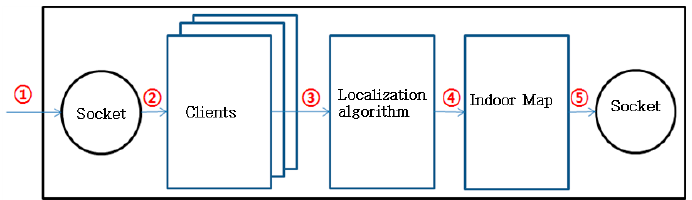
Figure 7. The Operation Process of the Localization Server. Figure 7. The operation process of the localization